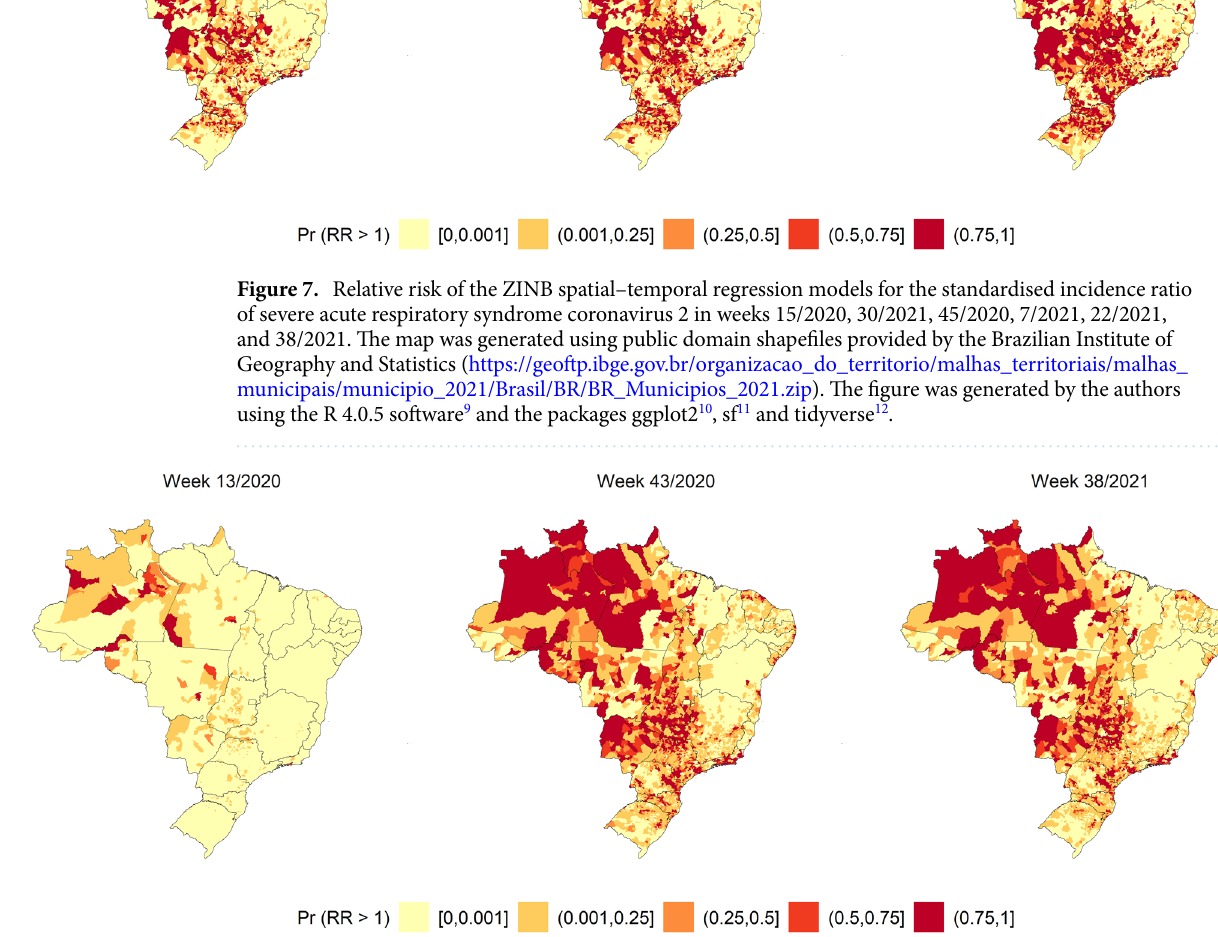
Figure 8. Relative risk of the ZINB spatial–temporal regression models for the standardised mortality ratio of severe acute respiratory syndrome coronavirus 2 in weeks 15/2020, 30/2021, 45/2020, 7/2021, 22/2021, and 38/2021. The map was generated using public domain shapefiles provided by the Brazilian Institute of Geography and Statistics (https:// geoftp. ibge. gov. br/ organ izacao_ do_ terri torio/ malhas_ terri toria is/